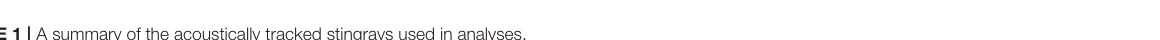
TABLE 1 | A summary of the acoustically tracked stingrays used in analyses. Species # Tracked # Males # Females Mean DW (cm) DW range (cm) Mean time at liberty (days) Pastinachus ater Urogymnus